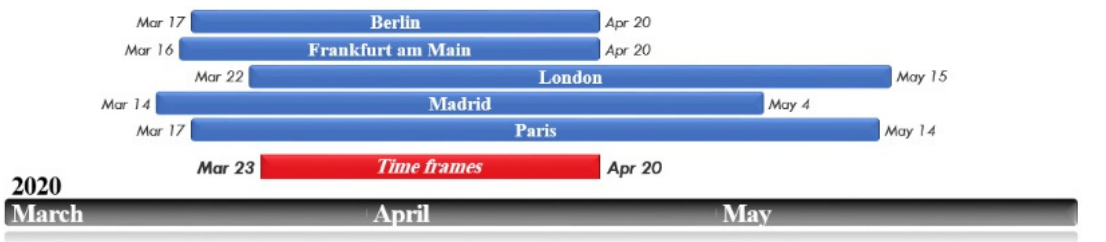
Figure 2. Time frames for severe restrictions on COVID-19 in each city and a common time frame for the whole study area.